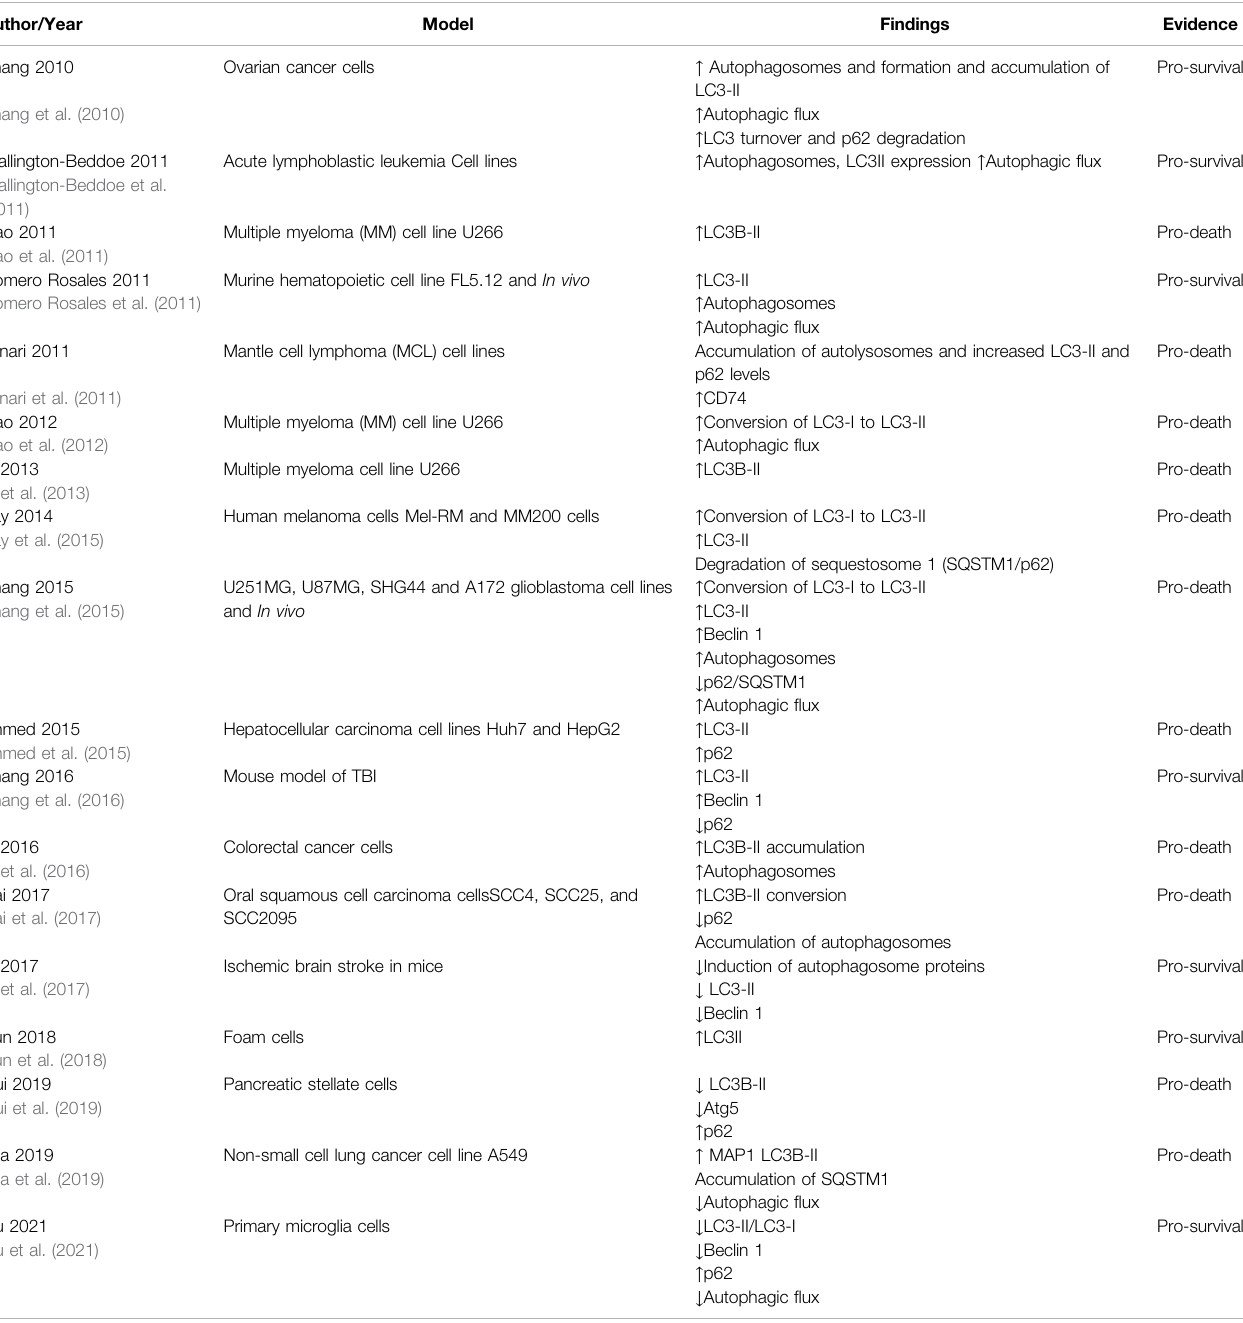
TABLE 1 | Fingolimod as an autophagy inducer/blocker and its role in cell